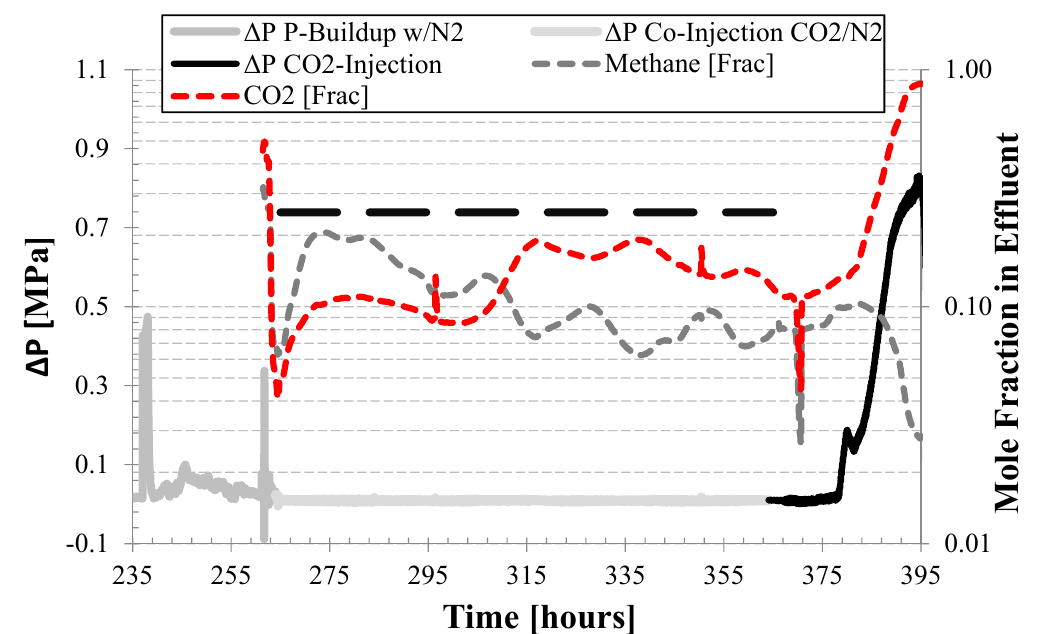
Figure 13. Effluent profiles suggest continued CO 2 -CH 4 exchange during binary gas injection, as the CO 2 molar fraction was consistently less than the injected CO 2